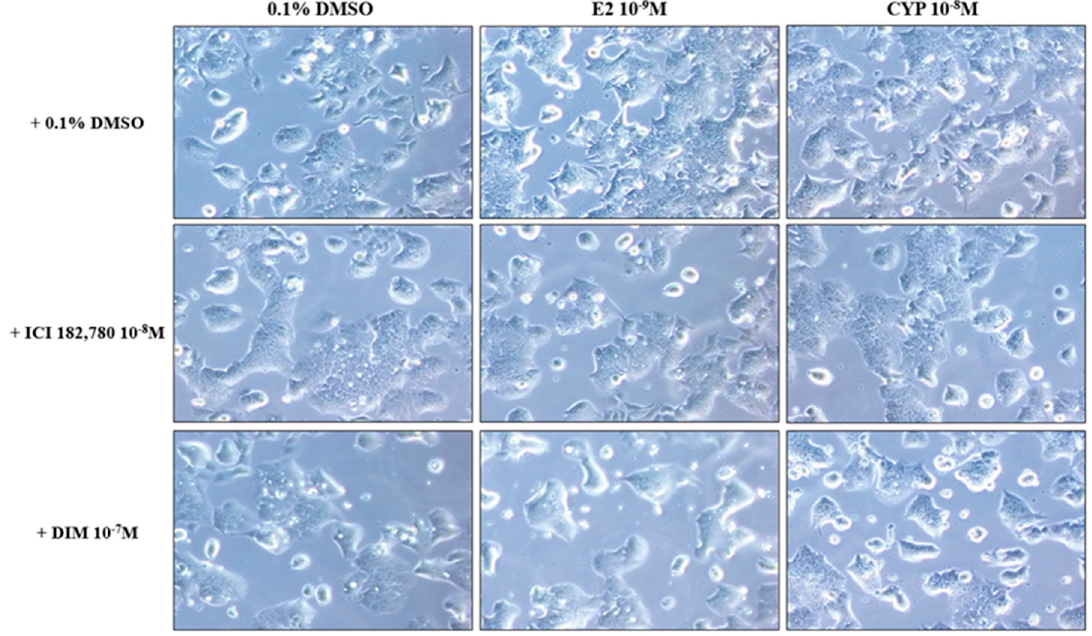
Figure 2 . Morphological changes in Ishikawa cells in response to treatment with E2 and CYP in the presence or absence of ICI 182,780 or DIM. Ishikawa cells were cultivated in six-well plates and treated with E2 (10 − 9 M), CYP (10 − 8 M), DIM (10 − 7 M), or ICI 182,780 (10 − 8 M) for 24 h. Ishikawa cells were photographed using a microscope at a magnification of 400×.